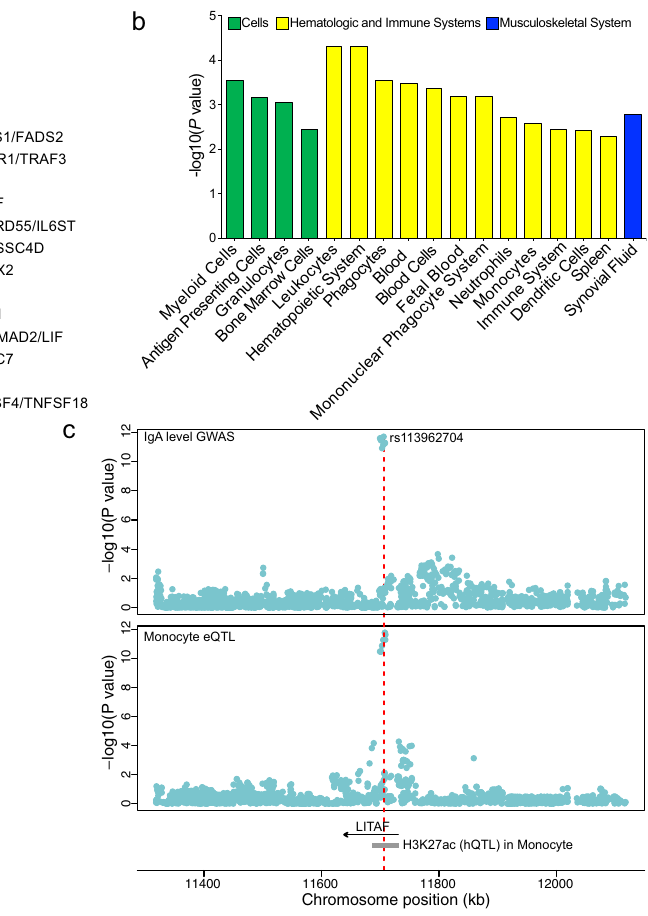
Fig. 4 | Colocalization and enrichment analyses across different tissue/cell types.a ColocalizationanalysiswithgeneexpressionQTLs(eQTLs)inwholeblood and primary immune cells; each row indicates one gene and each column denotes one tissue/cell type; the color from red to white shows the probability of sharing the same causal variant between GWAS loci and eQTLs (PP4). b Tissue/cell type enrichmentinDEPICT;the y -axisrepresentsthe − log10ofthetwo-sidedadjusted p - value for the enrichment test and x -axis shows the fi rst level MeSH tissue and cell